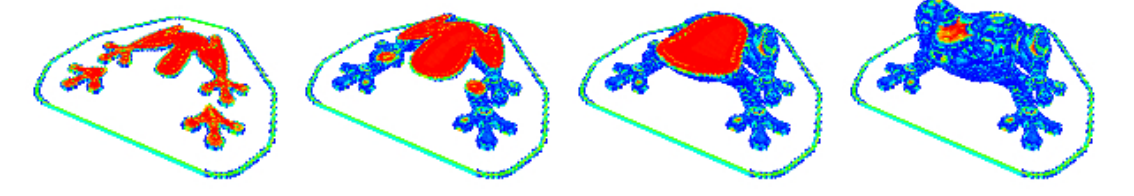
Figure 7. Activation sequence of the individual voxel elements. The colour of each voxel corresponds to its infill percentage (VOF). The centre of the print consists mostly of filled elements shown in red colour while blue elements near the surface of the printed part are almost empty.